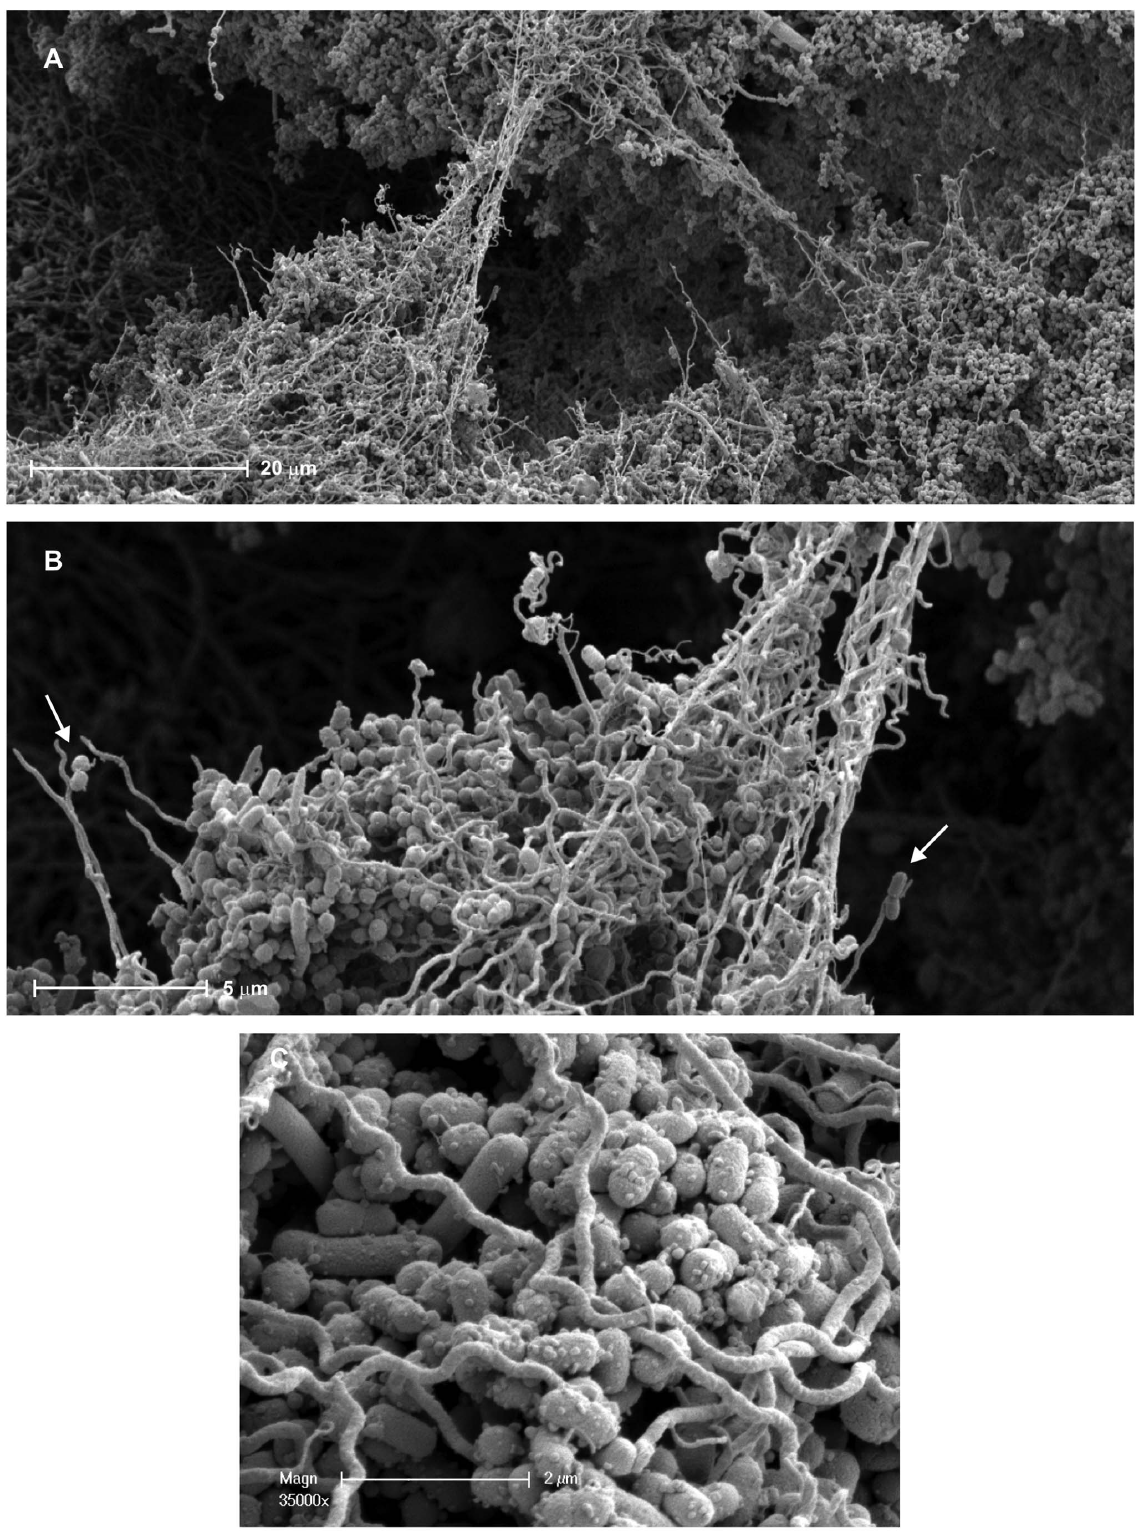
Figure 4. SEM micrographs of polymicrobial biofilms involving wild-type P.gingivalis , T.denticola and T.forsythia. T. dencicola , the long thin spirochaete; P. gingivalis , the smaller grape-like coccobacillus and T. forsythia the larger fusiform rod. Panels B and C are higher magnifications of sections in Panel A. (a) T. denticola forming bridges. (b) P. gingivalis attached to the ends of T. denticola projecting out of the microcolonies. (c) Outer membrane vesicles on the surface of P. gingivalis.